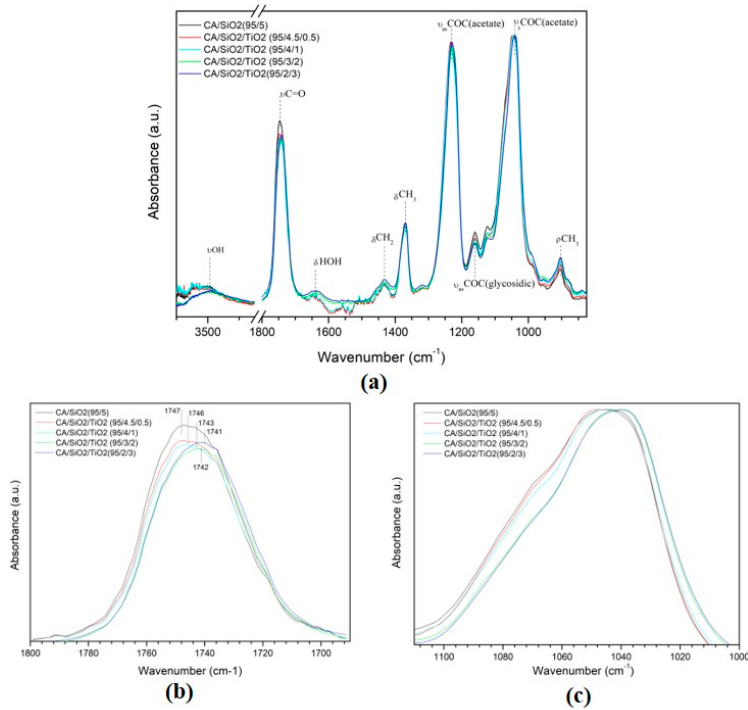
Figure 5. Attenuated total reflection (ATR) spectra of the active layer of CA / SiO 2 / TiO 2 membranes normalized to the C = O stretching band: ( a ) complete spectrum; ( b ) enhanced 1690–1800 cm − 1 region, and ( c ) enhanced 1000–1110 cm − 1 region. Table 3. Assignments of the ATR-FTIR spectra of the CA/SiO 2 /TiO 2 (series 1) membranes.